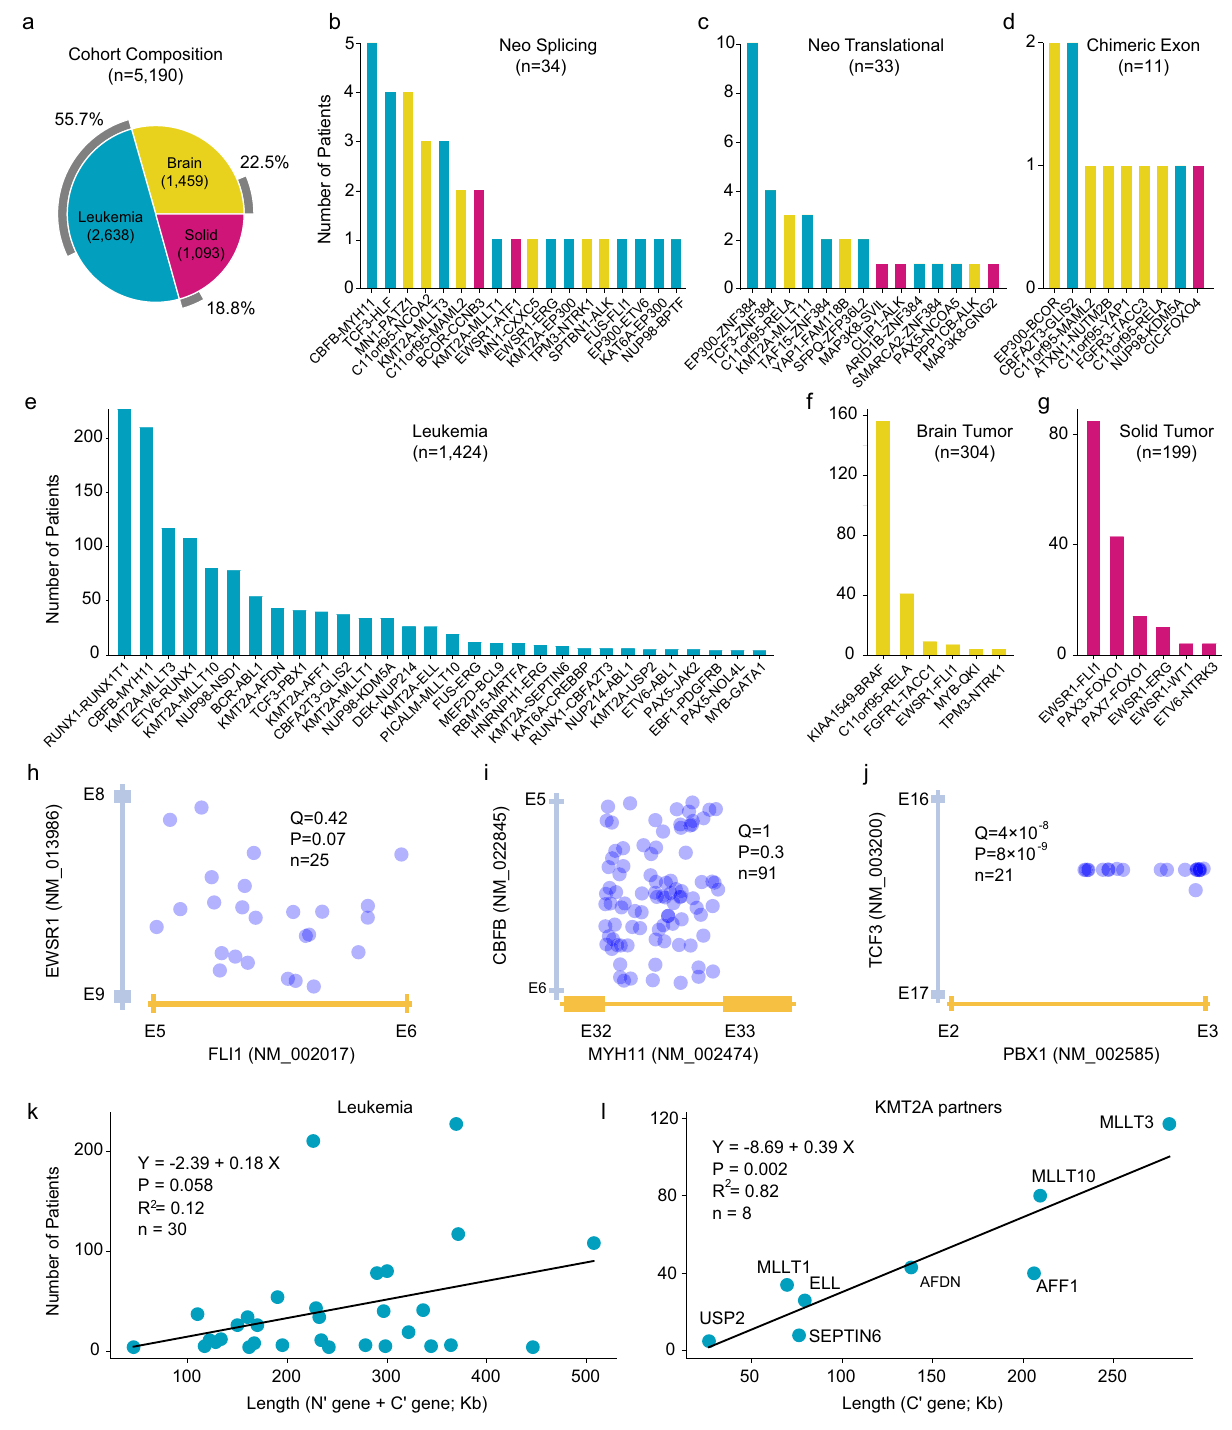
TCF3 - PBX1 ( j ). P values (and Q values after Bonferroni correction for multiple testing)of the uniformity test (two-sided Kolmogorov – Smirnov test;seeMethods) are indicated along with sample size in panels h – j . k Prevalence of oncogenic fusions ( y -axis) demonstrates a weak but marginally signi fi cant ( P =0.058) asso- ciation with gene length ( x -axis) in leukemia. l Statistically signi fi cant ( P =0.002) association between prevalence and gene length when the analysis is conditional on KMT2A- rearrangedleukemia.Linearmodel, P valueand R 2 valueareindicatedfor panels k – l .Sourcedataareprovidedaccordinglyas fi les a – g , h – j and k – l inSource Data fi